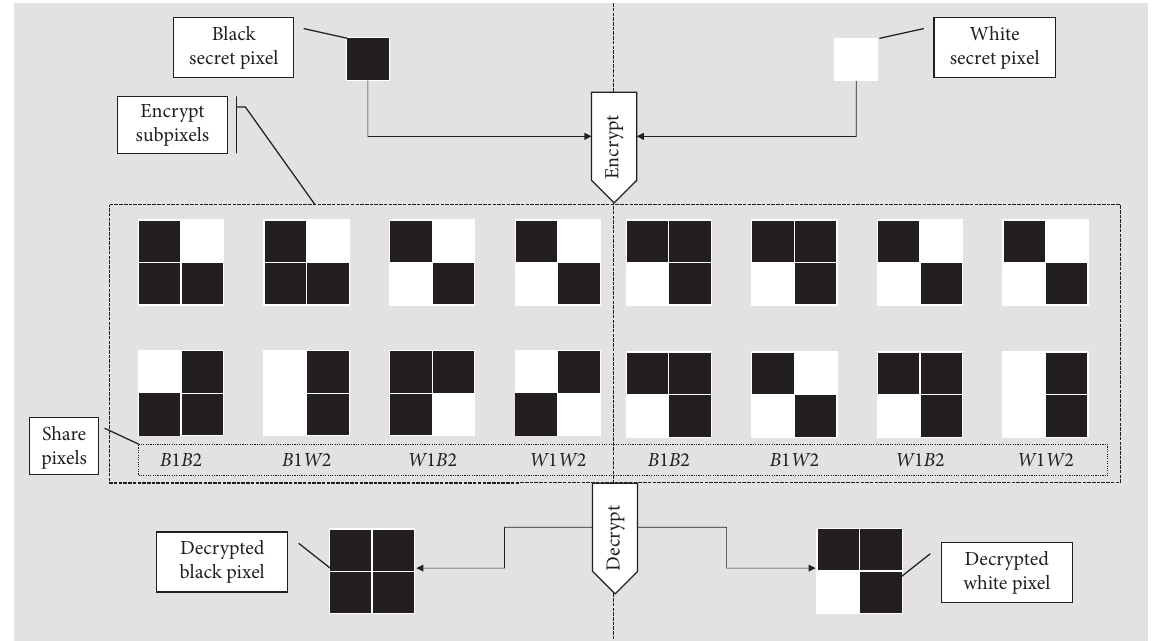
Figure 1: Illustration of a (2, 2)-EVCS for the black-and-white image. The left and right are the encryption and decryption procedure of a black and white secret pixel, respectively. The B 1 W 2 denotes that the corresponding pixels in Share 1 and Share 2 are black and white, respectively. The meanings of other symbols are